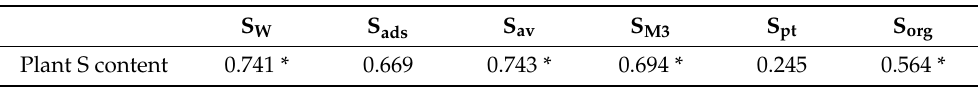
Table 7. Spearman’s correlation coefficient values comparing the relationship of plant sulfur content with soil sulfur content. S W S ads S av S M3 S pt S org Plant S content 0.741 * 0.669 0.743 * 0.694 * 0.245 0.564 *